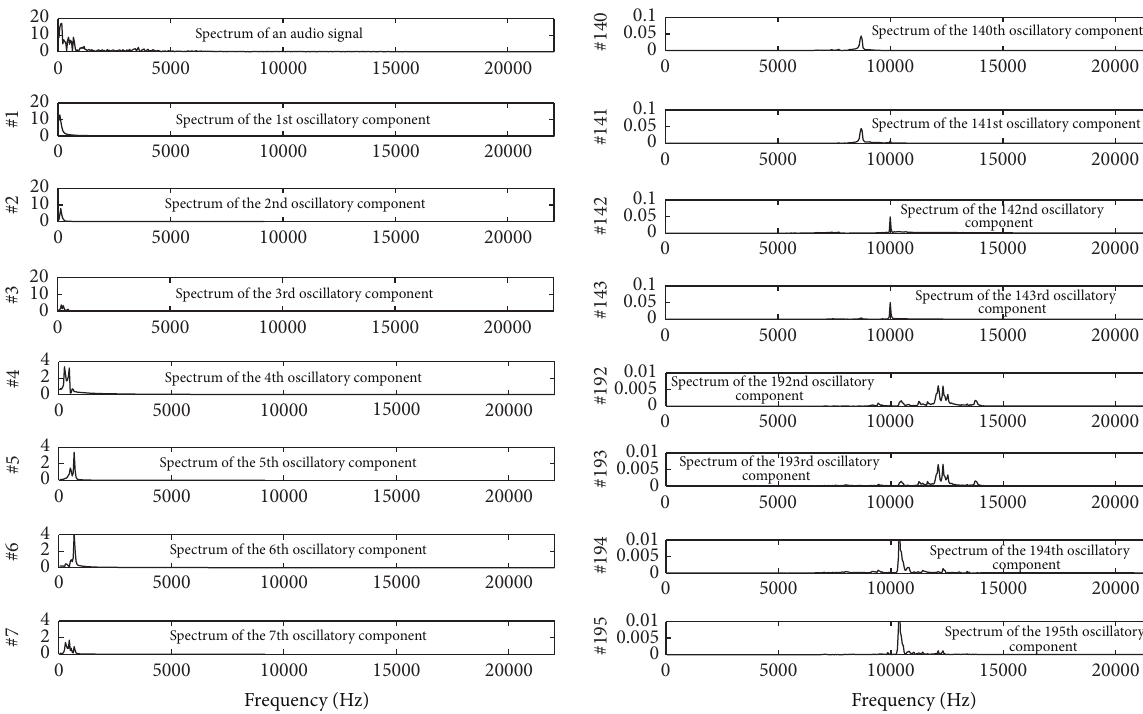
Figure 6: Examples of spectra of oscillatory components: the top-left panel is a spectrum of an audio signal, and the other panels show spectral of some oscillatory components. The numbers labeled on vertical axes are the orders of the components, which are indices of their associated singular values. Compared with the spectrum of the audio signal, the spectral of oscillatory components has narrower bandwidths.